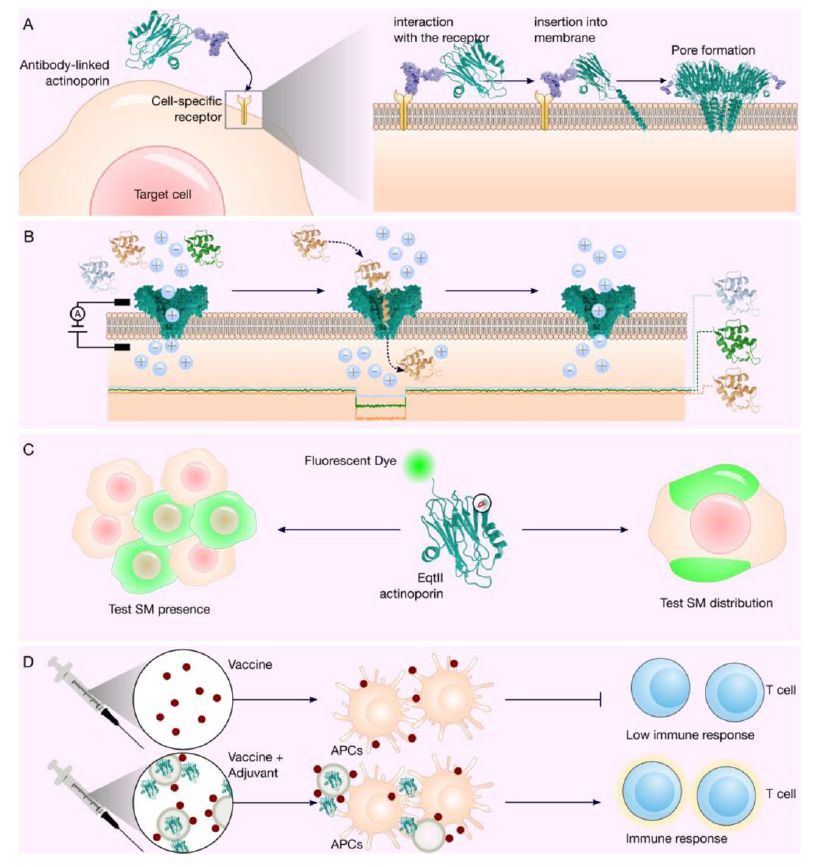
Figure 2. Actinoporin applications. A. Actinoporin-based immunotoxins act at the membrane